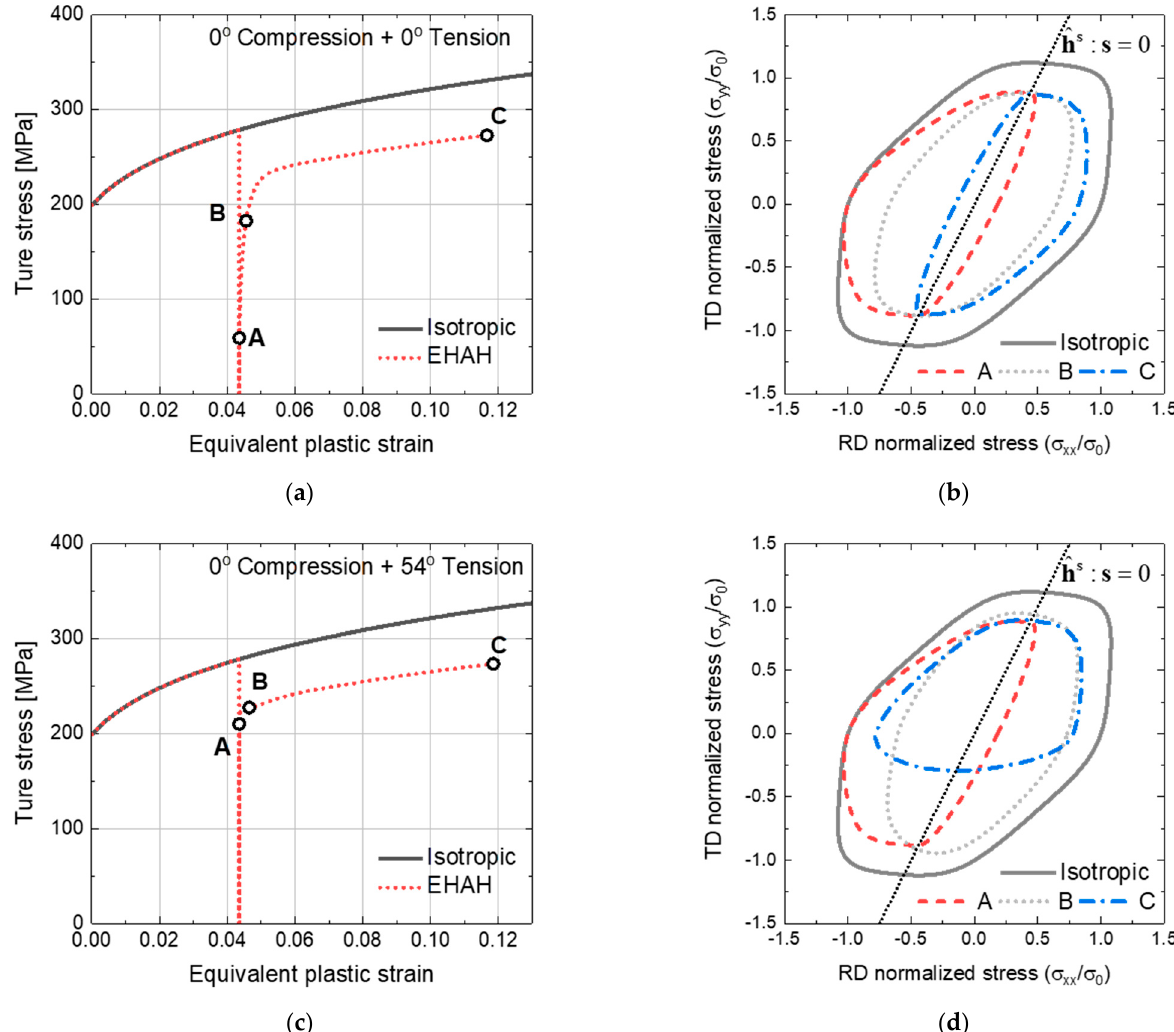
Figure 4. Stress − equivalent plastic strain curve and evolution of e − HAH yield surface for MAT 1: ( a ) flow stress curve and Figure 4. Stress-equivalent plastic strain curve and evolution of e-HAH yield surface for MAT 1: ( a ) flow stress curve and ( b ) e − HAH yield locus for C5T10R, and ( c ) flow stress curve and ( d ) e − HAH yield locus for C5T10CR. ( b ) e-HAH yield locus for C5T10R, and ( c ) flow stress curve and ( d ) e-HAH yield locus for